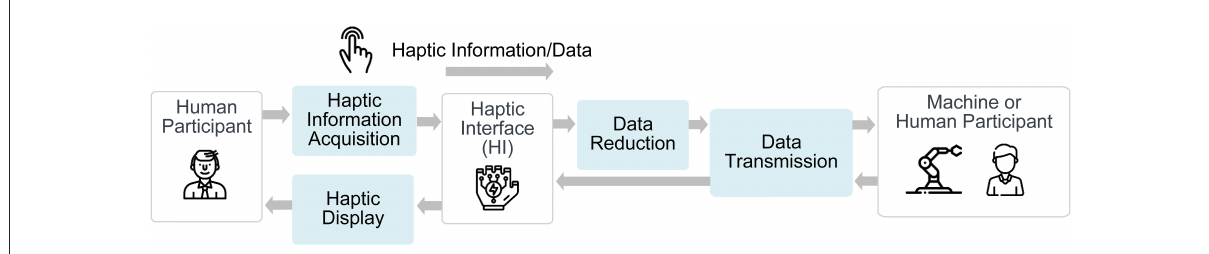
FIGURE5 Implementation procedure of bilateral haptic communication.